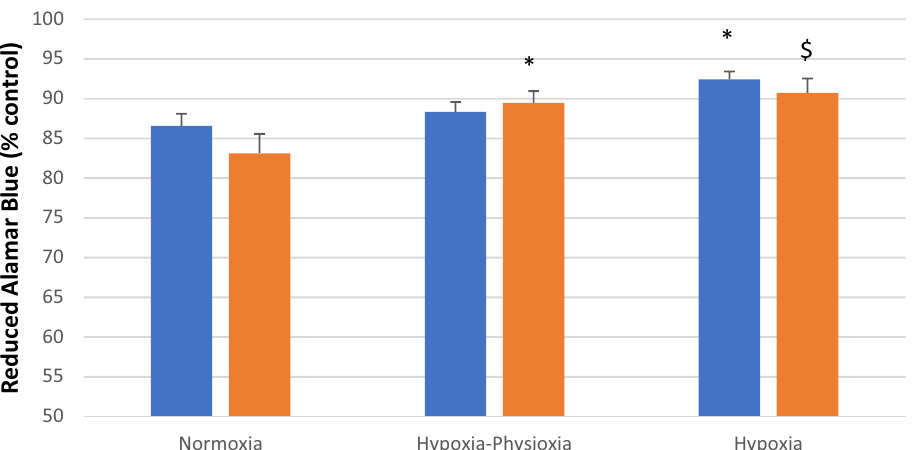
Figure 6. Effect of distinct oxygen tension conditions on cell sensitivity to radiation in vitro at different time points. Cell viability, measured by Alamar Blue Assay relative to the control (of untreated cells in corresponding oxygen condition), as a percentage is shown after 48 and 72 h of exposure to beta radiation. N = 2 biological replicates in 6 technical replicates; bars show mean + /- SEM, * p value < 0.05, $ p value < 0.1 in comparison to normoxia.